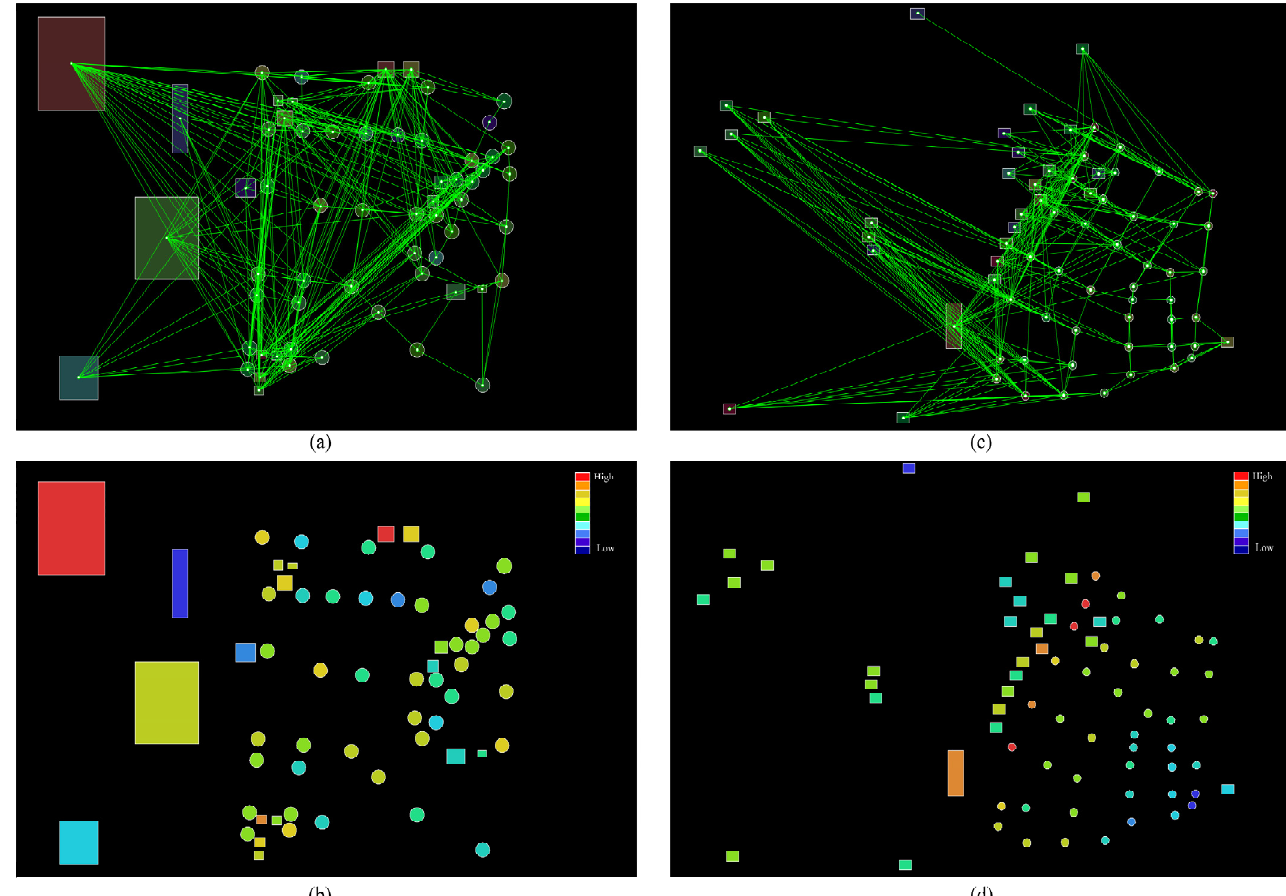
Figure 14. Space syntax computation. ( a ) 3D NL GAM of the TP-District, ( b ) NAIN of each node and landmark in the TP-District, ( c ) 3D NL GAM of the XD-District, ( d ) NAIN of each node and landmark in the XD-District.